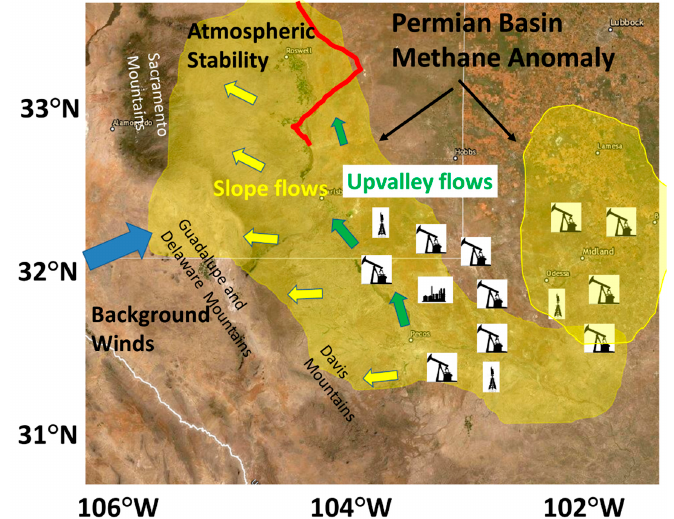
Figure 10. Schematic illustration of the Permian Basin methane anomaly region noted from TRO- POMI and hypothesized meteorological